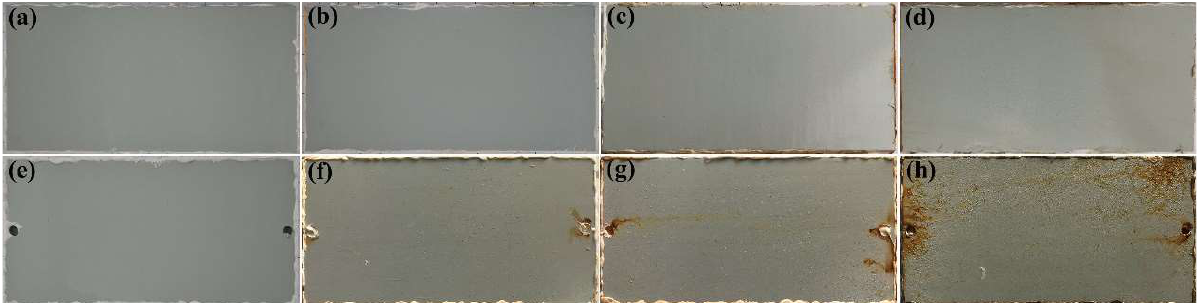
Figure 3. The surface topography of the samples at different period of salt spray test; ( a – d ) the topography of the coating with composites fillers after 0 d, 3 d, 6 d, and 10 d, respectively; ( e – h ) the topography of the coating without fillers after 0 d, 3 d, 6 d, and 10 d, respectively.